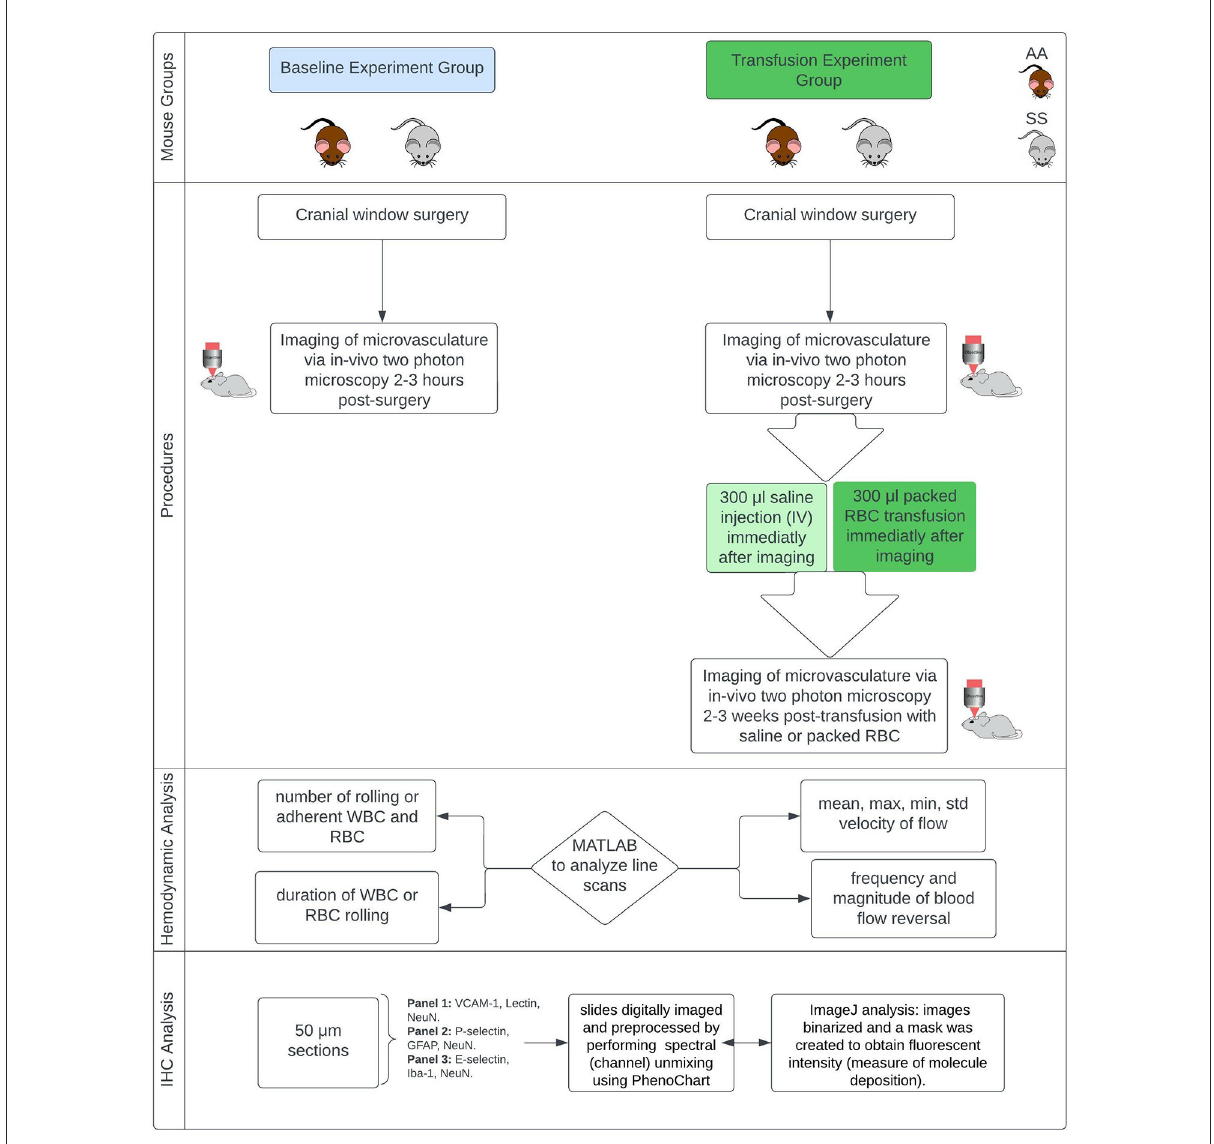
FIGURE1 Overview of methods. Townes mouse model, a humanized sickle cell (with HbSS) and control (HbAA) mouse model (12–13 months). IHC, immunohistochemistry.